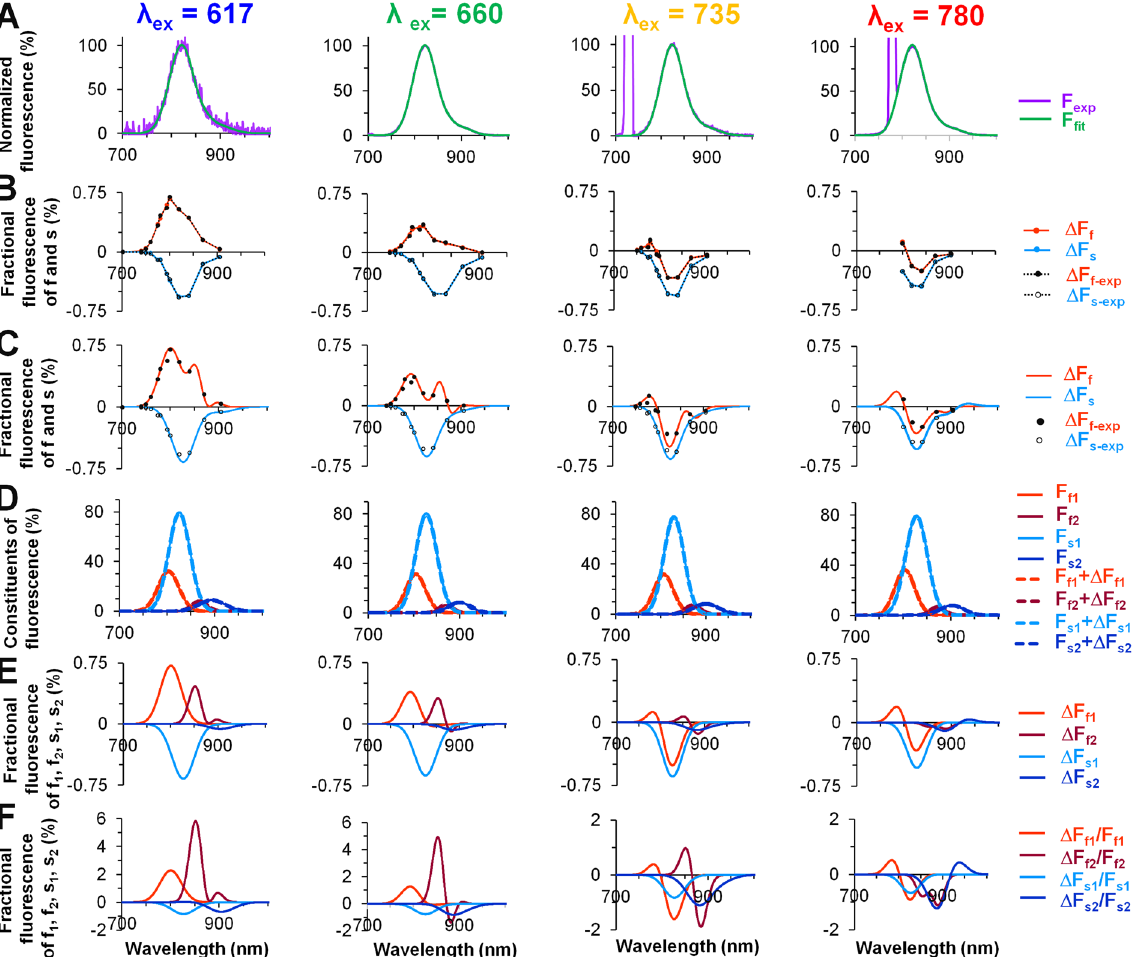
Figure 3. Mean values of the ICG OS fluorescence spectra obtained experimentally or calculated by applying a model with four Gaussian functions. The records shown were obtained at 1 µ M ICG (n = 9) and at various excitation wavelengths: λ ex = 617 nm ( blue ), λ ex = 660 nm ( green ), λ ex = 735 nm ( yellow ), and λ ex = 780 nm ( red ). ( A ) The superimposition of normalized emission spectra obtained with a spectrometer ( noisy ) and calculated obtained spectra using a four-Gaussian approximation ( smooth ). ( B ) Two voltage-sensitive components with distinct spectral properties were isolated from the ICG fluorescence spectrum recorded with a fast EMCCD camera at the corresponding emission filters (black circles: filled for fast and open for slow component) and the calculated values ( red for fast and blue for slow) are shown. ( C ) The same graph as in ( B ) with the calculated data presented as a continuous curve. ( D ) Splitting of the results into four distinct constituents from the spectra presented in ( A ), two by two: fast ( red and dark red ) and slow ( blue and dark blue ). ( E , F ) Fractional changes in all four constituents when the total fluorescence signal, F, is normalized to 100% ( E ) and when the fluorescence of each individual constituent (F f1 , F f2 , F s1 , and F s2 ) is normalized to 100% ( F